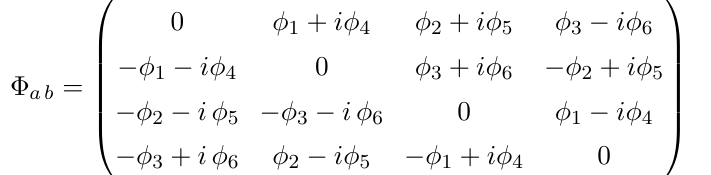
(cid:8) ab in (E.5). *(cid:17)